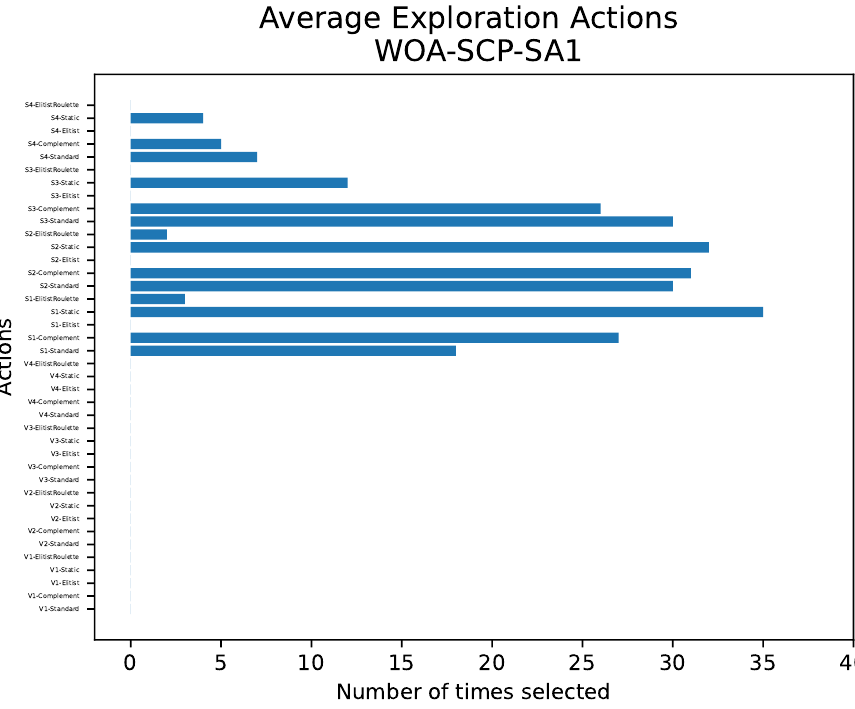
Figure 7. WOA-SA1—The average number of actions in the exploration